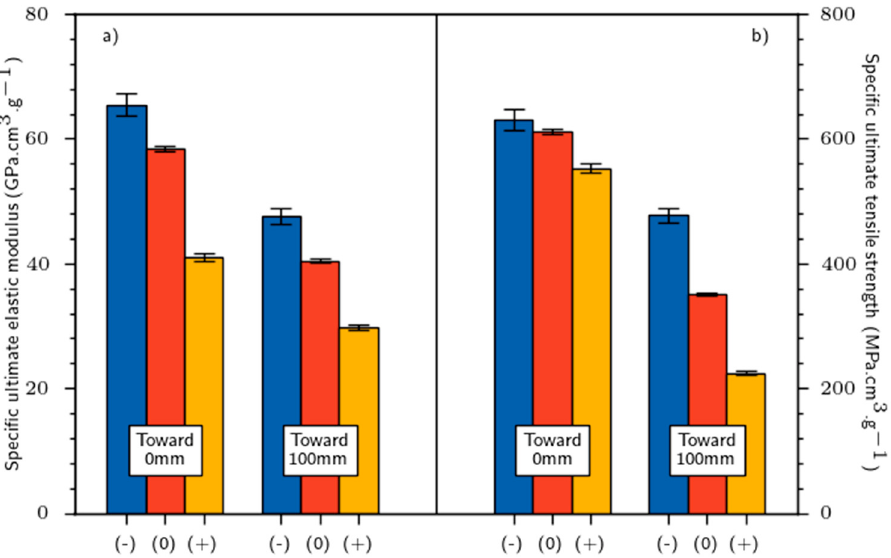
Figure 3. Tensile tests for flax fibers: ( a ) specific elastic modulus et ( b ) specific tensile strength .